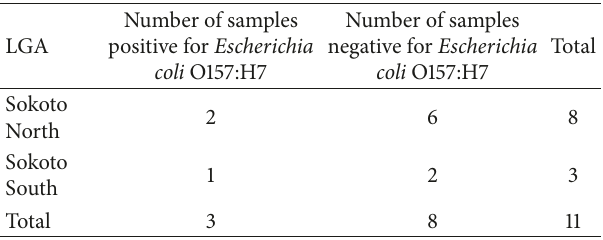
Table 5: Frequency of Escherichia coli O157:H7 isolates from raw milk in two Local Government Areas